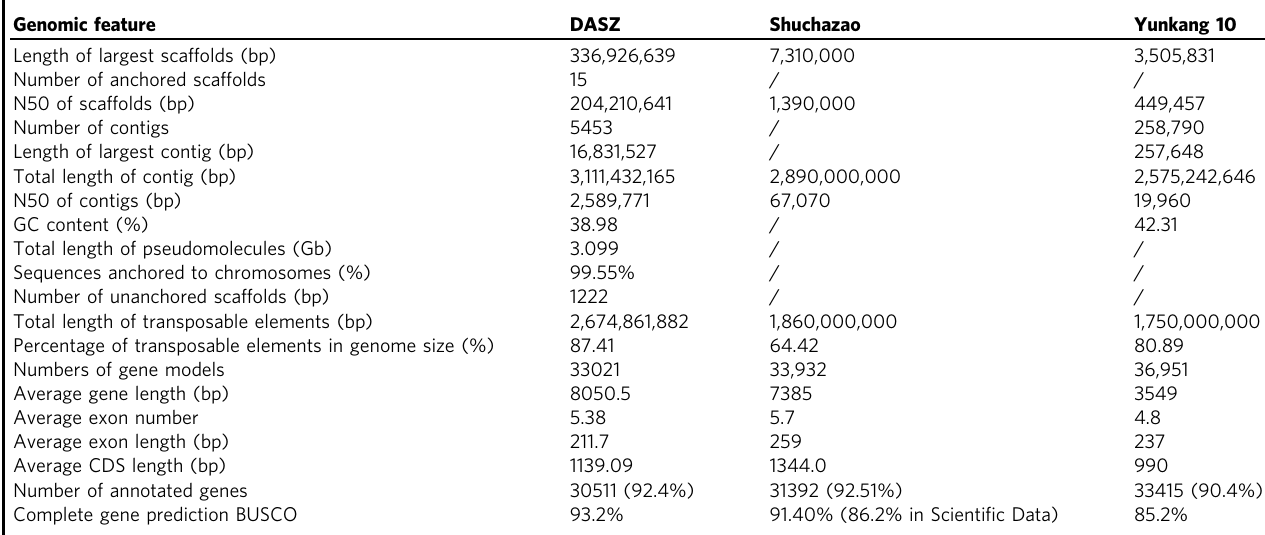
Table 1 Summary statistics of DASZ assembly genome compared with that of Shuchazao and Yunkang 10. Genomic feature DASZ Length of largest scaffolds